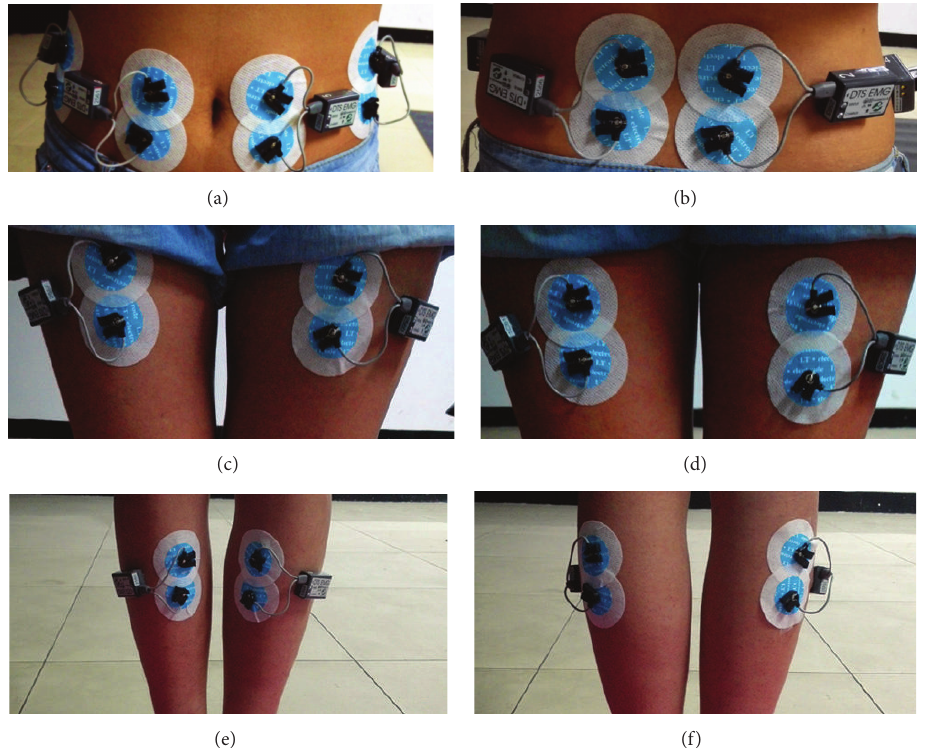
Figure 1: Electrode position of both left and right sides of muscles. (a) was the RA and EO muscles, (b) was ES muscle, (c) was RF muscle, (d) was BF muscle, (e) was AT muscle, and (f) was G muscle.